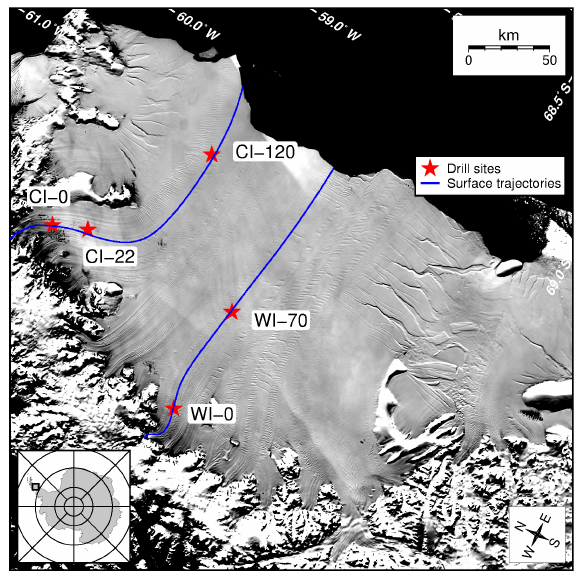
Figure 1. Mosaic of Antarctica (MOA2009) image of Larsen C Ice Shelf (Scambos et al., 2007; Haran et al., 2014) with borehole loca- tions and Cabinet and Whirlwind Inlet surface flow